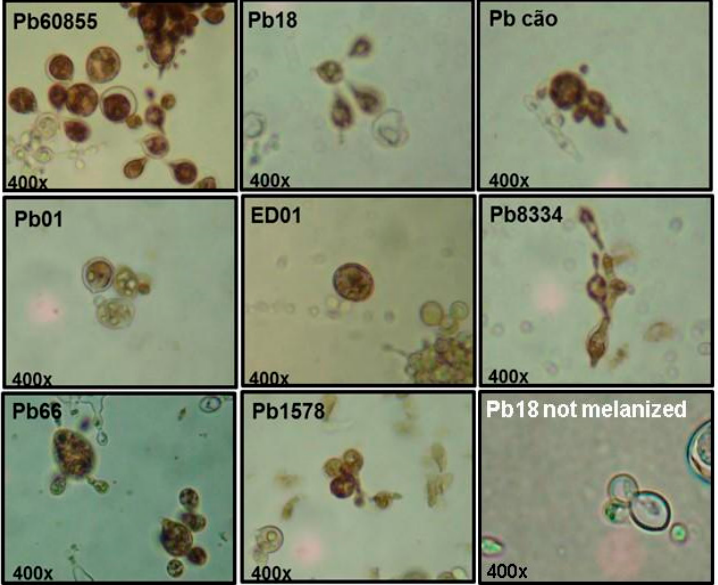
Figure 3. A panel of Paracoccidioides spp. yeast. Pb60855, Pb18, and Pbcão and P. lutzii (Pb01, ED01, Pb8334, Pb66, and Pb1578) were cultured in SMVMM liquid medium with L-DOPA, 37 °C, 150 RPM, for 15 days and then observed under light microscopy, 400× magnification. Pb18 “not melanized” represents Pb18 cultivated in the absence of L-DOPA.